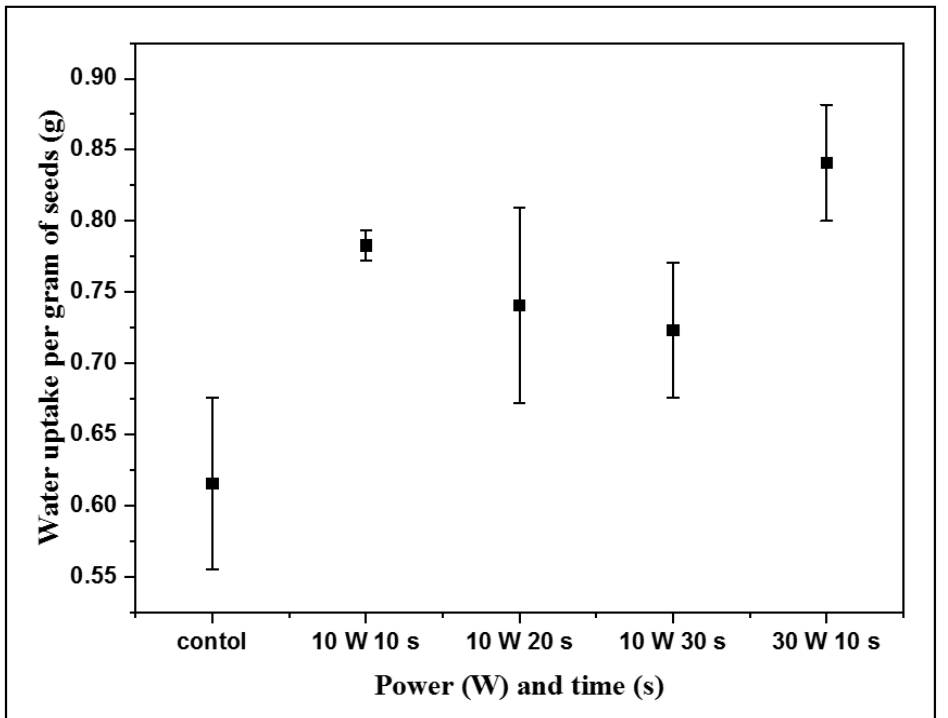
Figure 5. Water uptake of H 2 O-LPP treated and untreated Bambara groundnut seeds, measured for ~5 g of Bambara groundnuts before being normalized per unit gram. Experiments were performed in five replicates, n = 5 (20 seeds, i.e., ~5 g, were used in each replicate). Error bars refer to the standard deviations of the five replicates.